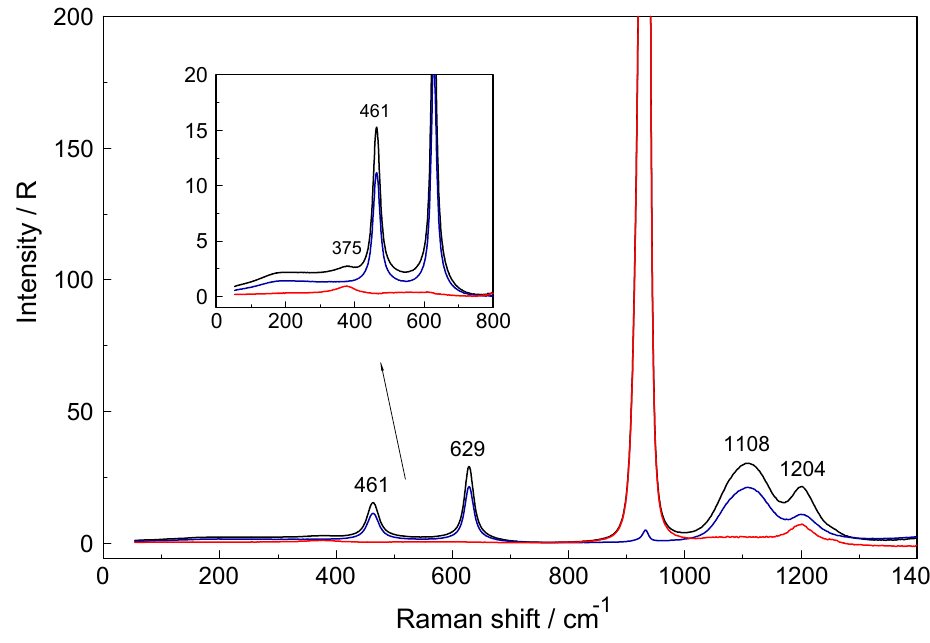
Figure 4. Raman scattering profiles in R-format (spectra from top to bottom: R VV , R VH and R iso ) of a 0.779 mol·L − 1 Yb(ClO 4 ) 3 solution in D 2 O. The inset shows the low frequency region in larger detail.